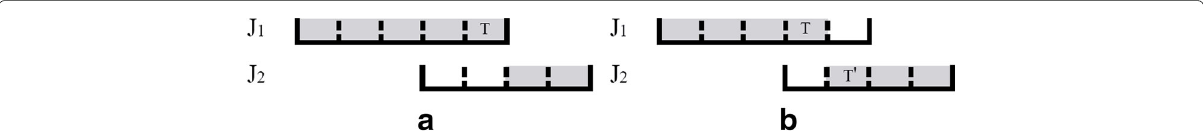
Fig. 2 a , b Job link examples